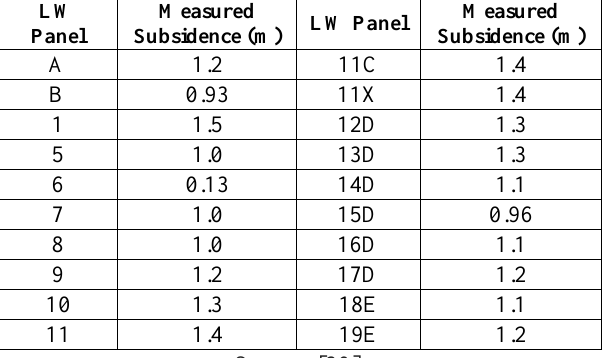
Table 3: Measured subsidence of old Ulan coal mine panels. LW Panel